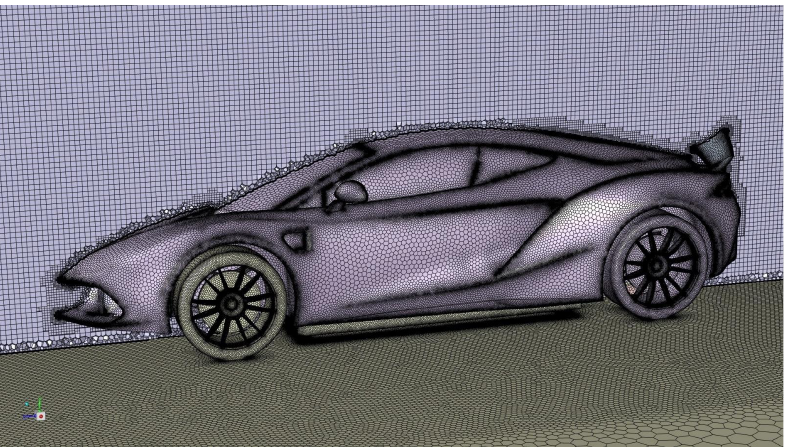
Figure 21. Computational mesh in a cross-section.